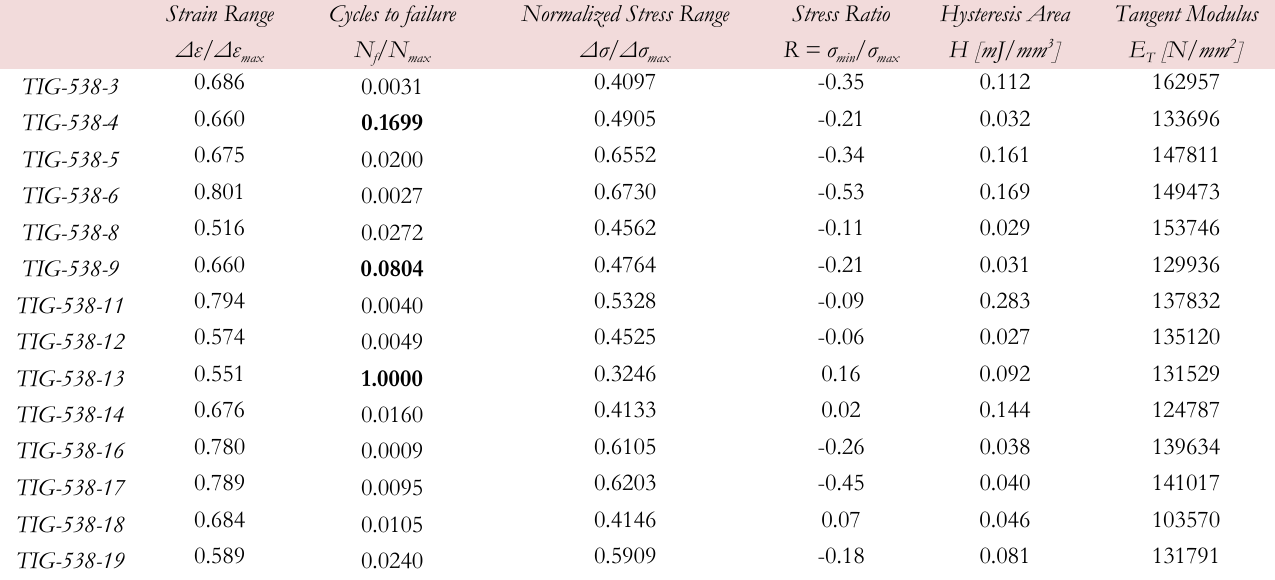
Table 5: TIG Welded Material – 538°C: fatigue test